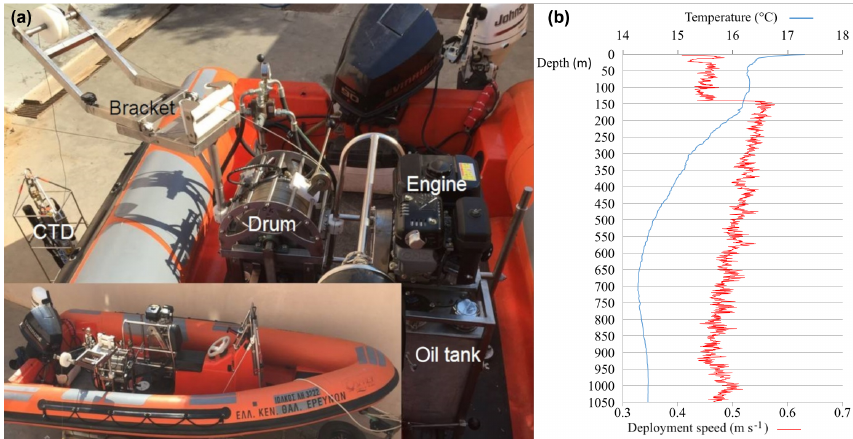
Figure 11. (a) Hydraulic winch positioned on a small RIB allowing casts > 1000m (Pettas et al., 2015); (b) temperature and deployment speed against depth from a CTD cast made using the hydraulic winch. Deployment speed decrease above 150m was made in order for the CTD to respond better to rapid environment changes like